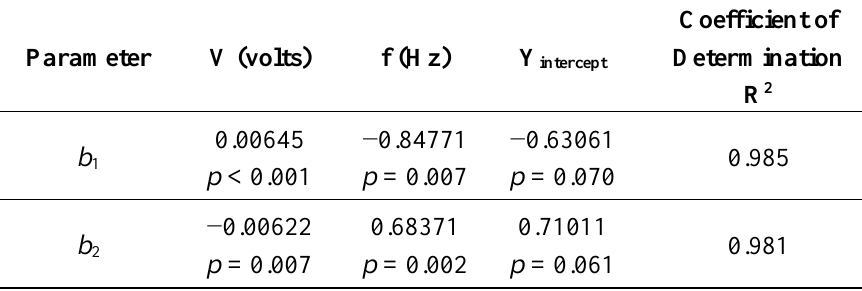
Table B2. Regression analysis for the saturation